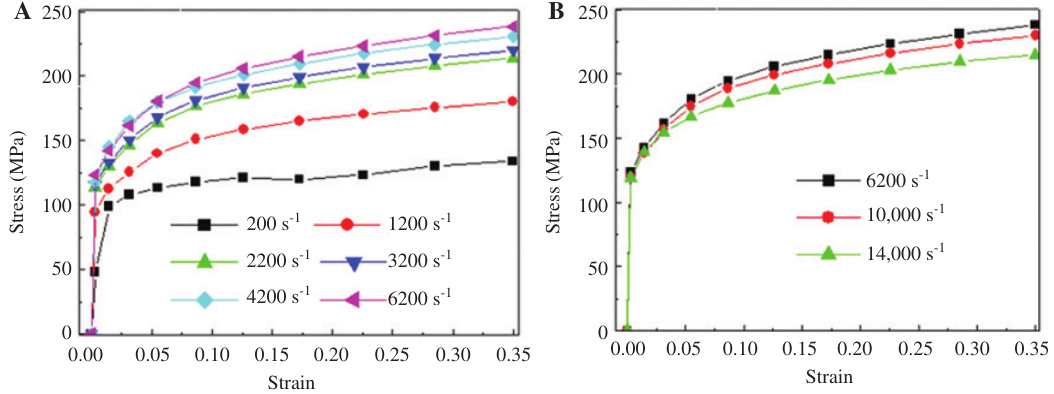
Figure 2 Stress-strain behaviors of SiCp/Al composites at different strain rates.